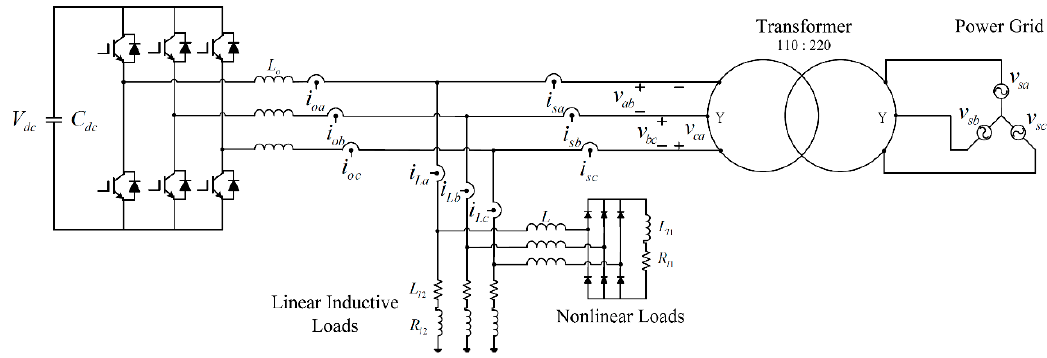
Figure 1. Circuit architecture of DSTATCOM with nonlinear and linear inductive loads.